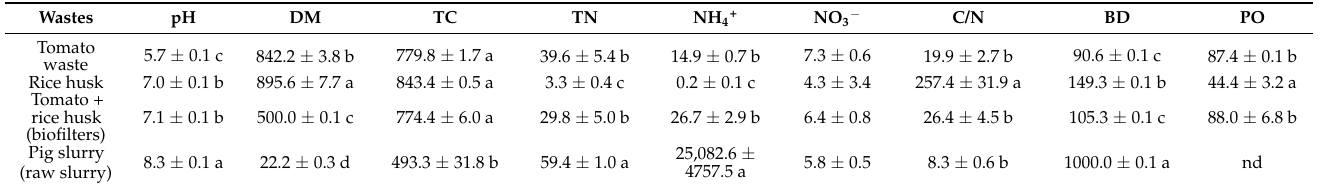
Table 1. Physicochemical characteristics of the packing materials and pig slurry used in the experi- ment (mean ± standard deviation) ( n =